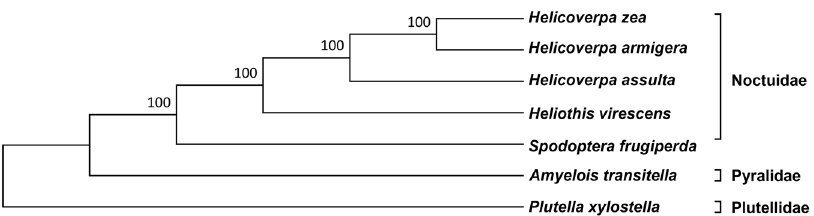
Figure 2. Phylogenetic tree of insect L-ACY-1 based on their amino acid sequences. Phylogenetic tree was constructed using the neighbor-joining method with 1000 bootstrap replicates. The numbers at each tree node are the bootstrap